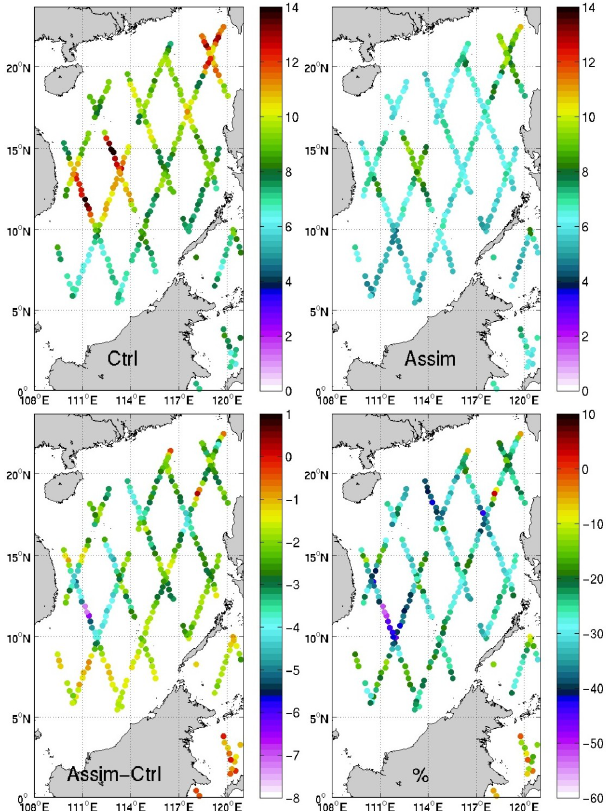
Table 1. Estimation of the residual tidal heights for different filters